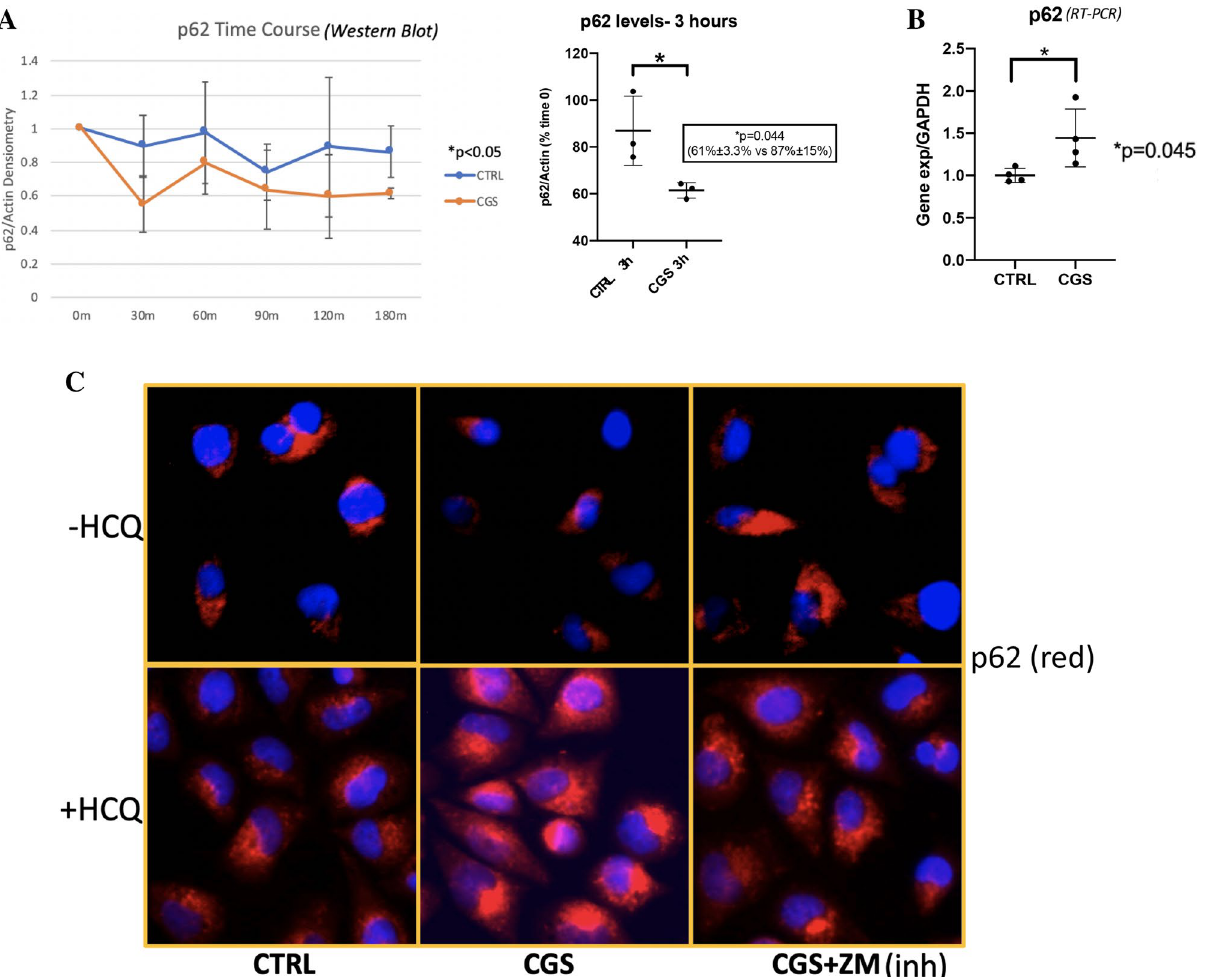
Figure 2. Autophagy protein p62 analysis shows A2AR agonism increases autophagic flux. Of note, p62 protein is directly bound to cargo in the autophagosome leading to its degradation by lysosomal proteases. Hence, its degradation can be used as a positive marker of autophagy. ( A ) Western blot time course for p62 levels from TC28 ⍺ 2 cells all in starvation media with FBS reduced from 10 to 1% and treated ± 1 µM CGS with line graph trend below (+ CGS, blue line, -CGS, orange line). Densitometry of p62 was compared to that of actin and normalized to time 0 are plotted for the time points with time course analysis by time series mixed model ANOVA (time series CGS vs. CTRL 0.74 ± 0.17 vs. 1.0 ± 0.24, * p < 0.05, n = 3 per time point per group). Individual comparison of 3-h CGS vs. CTRL sample sets showed statistically significant percent decrease in p62 by 3 h compared to time 0 in treated vs. untreated (61% ± 3.3% vs. 87% ± 15%, p = 0.044, n = 3). ( B ) p62 mRNA levels were measured in vitro after CGS treatment. CGS vs. CTRL was significantly increased (1.44 ± 0.34 vs. 1.0 ± 0.082, p = 0.045, n = 4). ( C ) TC28 ⍺ 2 human chondrocytes were stained for p62 (red) by IF at 1 h after CGS treatment. CTRL, untreated; CGS, treated A2AR agonist; CGS + ZM, A2AR antagonist pre-treatment with A2AR agonist treatment. Representative cells at 40 × HPF from 4 repeated experiments per